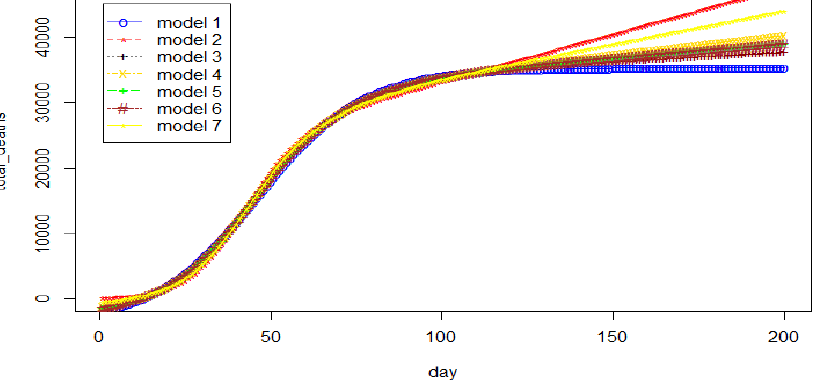
Figure 7. The estimated cumulative number of deaths vs. day in